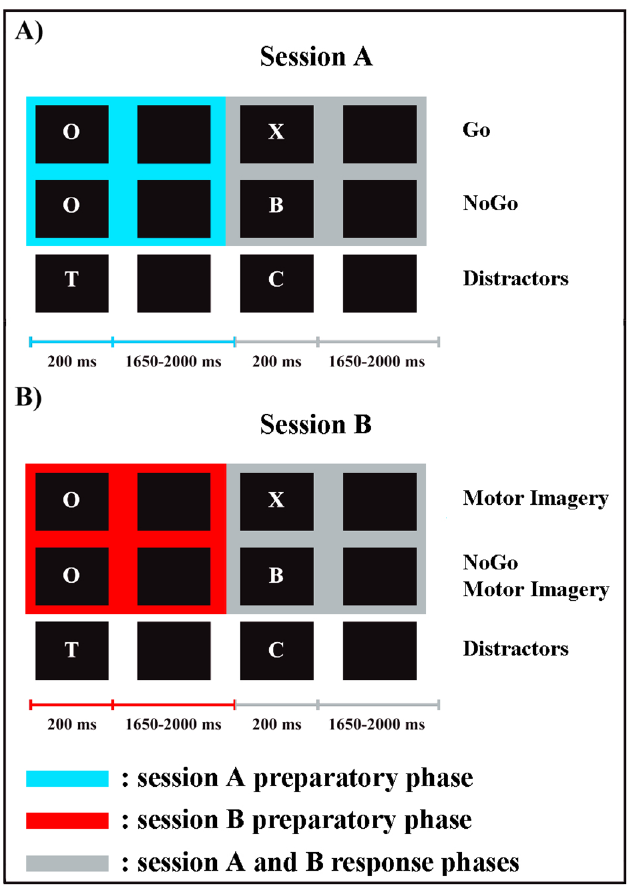
Fig 1. Experimental paradigm and stimuli. The present study analyzed the preparatory phases of sessions A and B (for the analyses of the response phases of both sessions, see [12]).